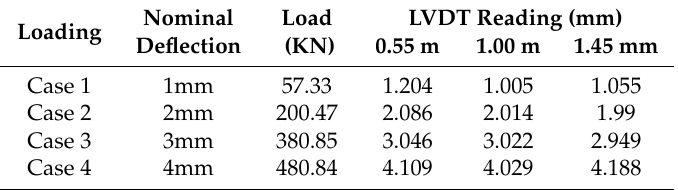
Table 2. Load cases and LVDT readings for the corresponding nominal